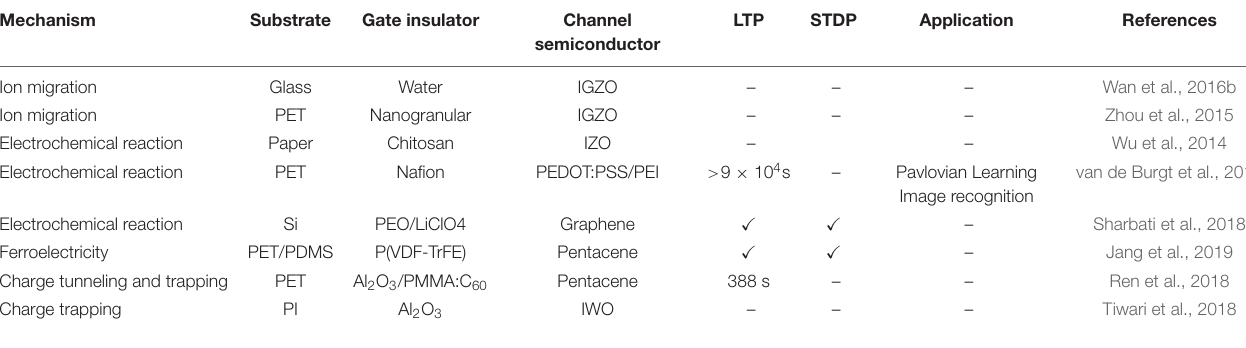
TABLE 2 | Summary of 3-T artificial synaptic devices based on various materials and mechanisms.